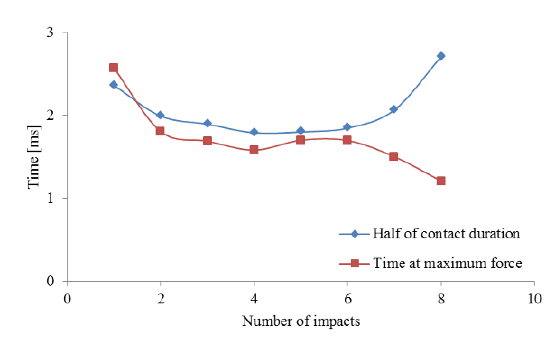
Figure 10. Half of contact duration and time at maximum force vs. the number of repeated